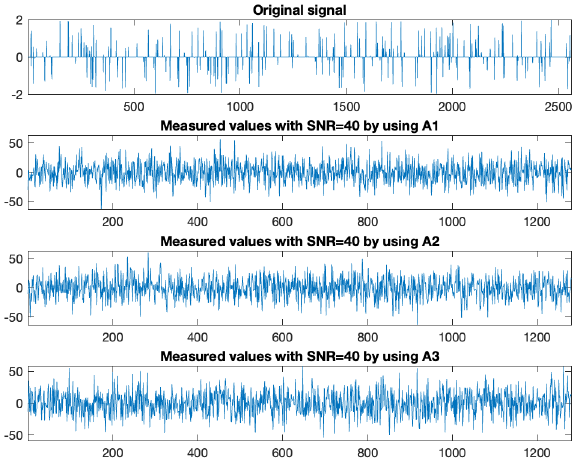
Figure 13. The original signal size N = 2560, M = 1280, and 250 spikes and the measured values with A i , i = 1,2,3, SNR = 40, respectively.